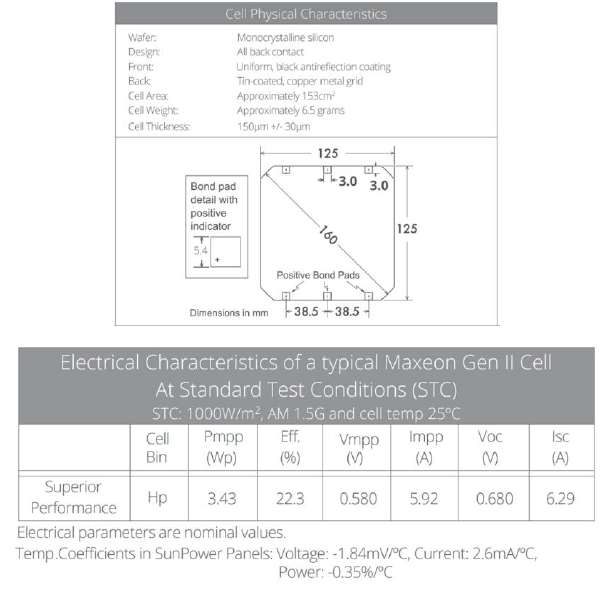
Figure 1. Sunpower’s Maxeon Gen II Cell specifications.